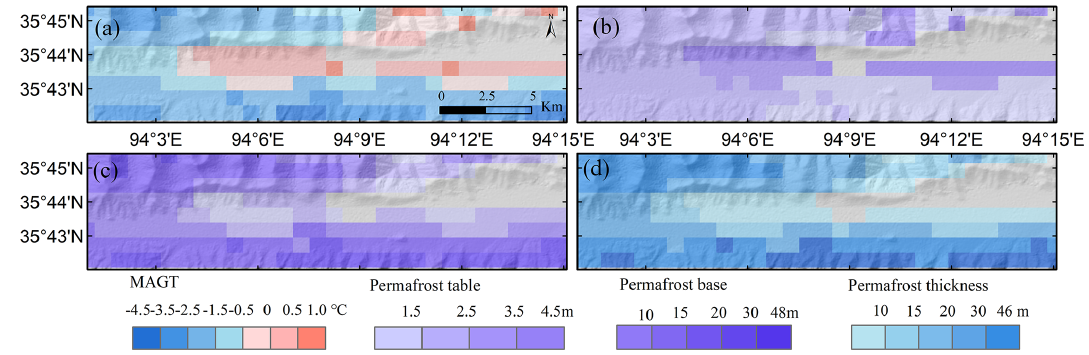
Figure 4. Spatial distributive features of the MAGT (a) , permafrost table (b) , permafrost base (c) , and permafrost thickness (d) for the initial simulation of the 1970s over Xidatan (grey areas with the seasonally frozen ground were excluded).